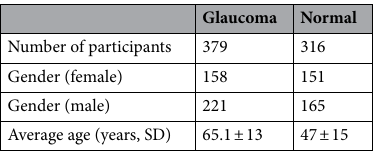
Table 1. Participant demographics and data